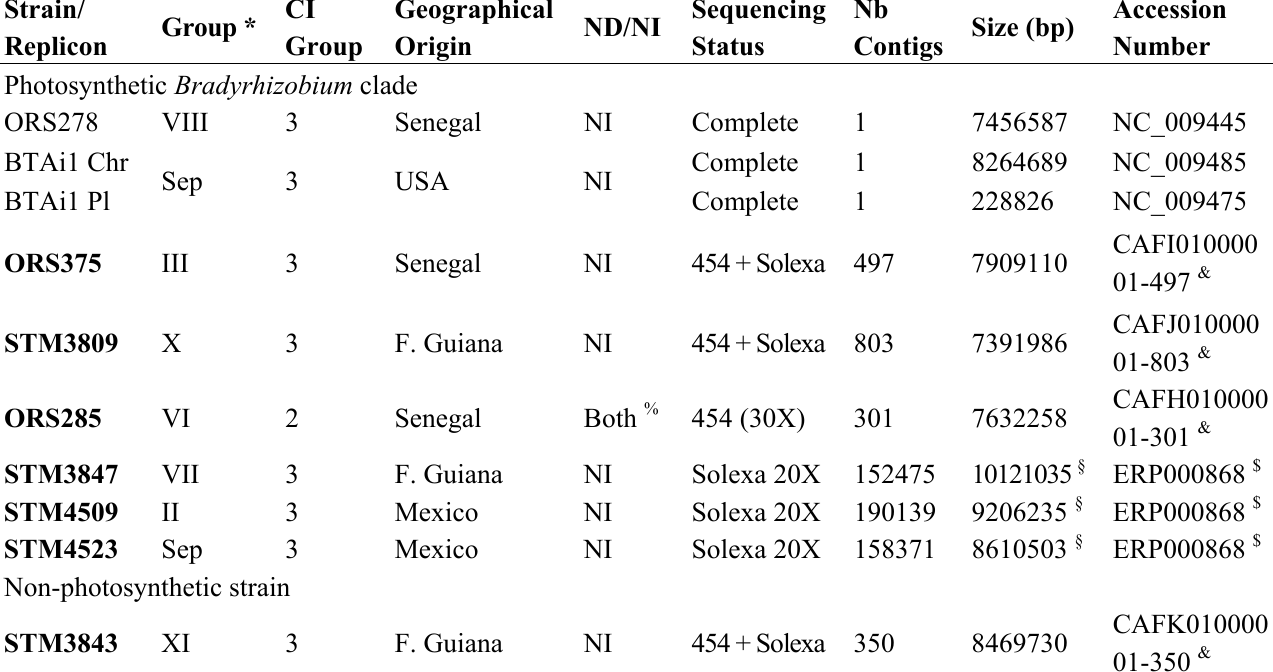
Table 1. Bacterial strains and genome sequencing